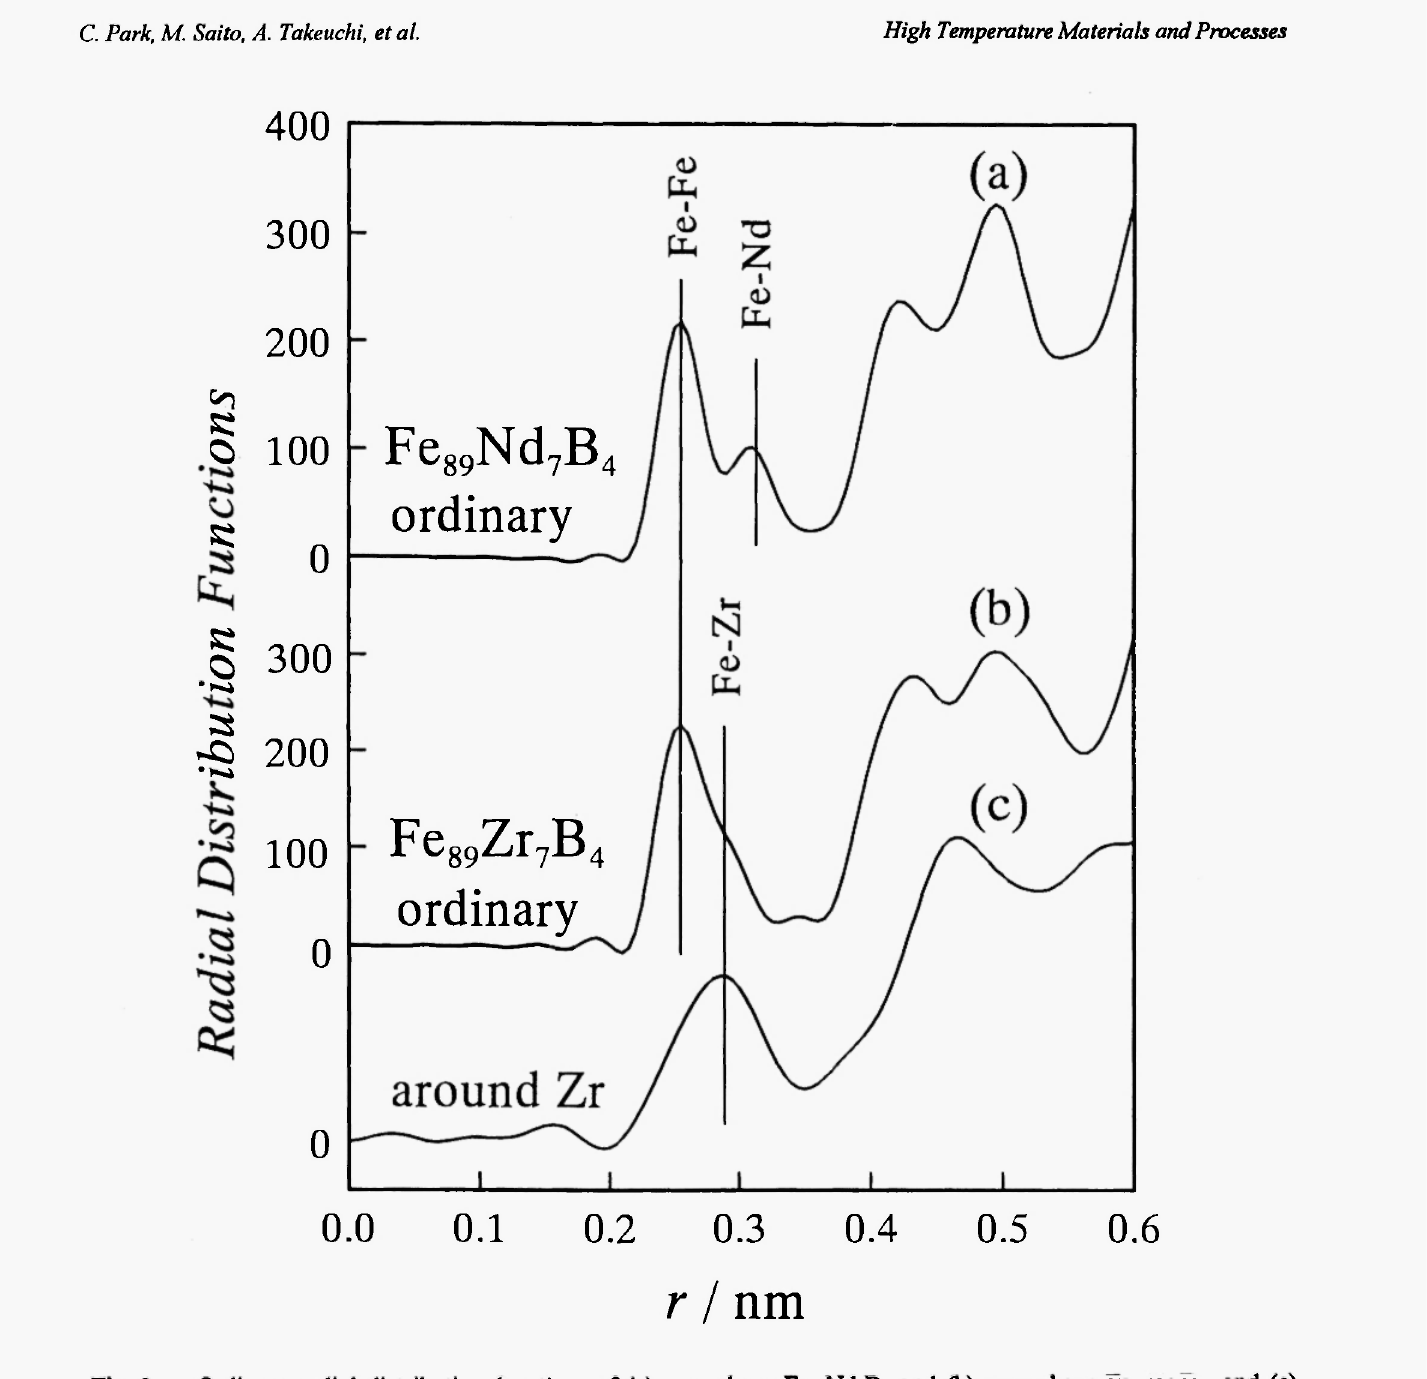
Fig. 3: Ordinary radial distribution functions of (a) amorphous Feggl^B« and (b) amorphous and (c) environmental radial distribution function around Zr of amorphous Fe^ryB^.